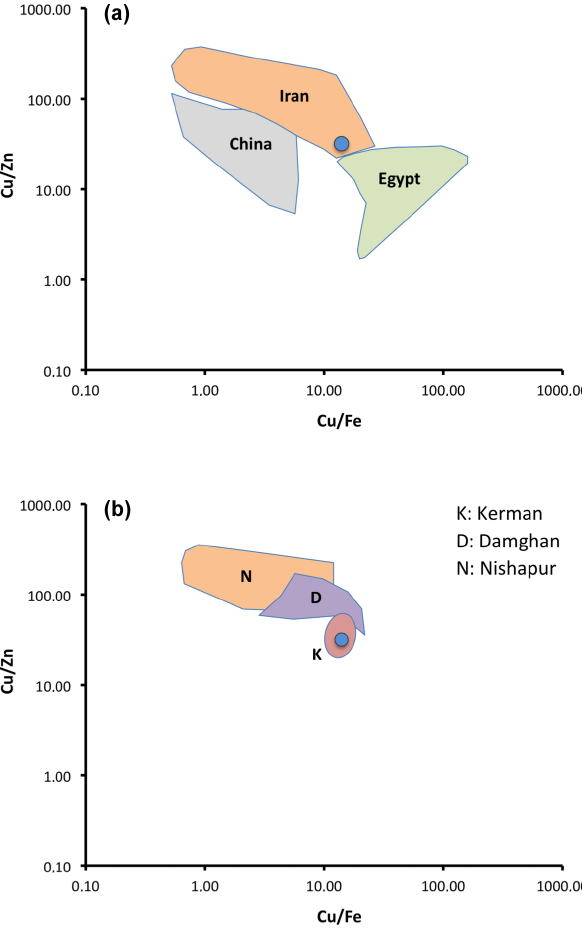
Figure 8. Cu / Zn vs. Cu / Fe diagrams established by Carò et al. (2017) in which the chemical compositions of turquoise from the reliquary crown of Namur are